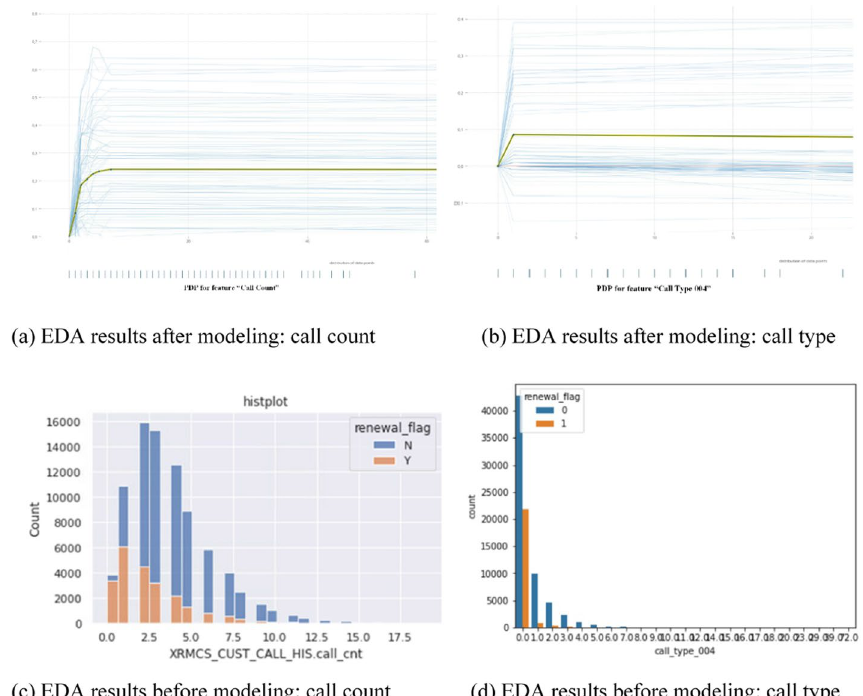
Fig. 16 Analysis result of Call Count and Call Type 004 variable. a EDA results after modeling: call